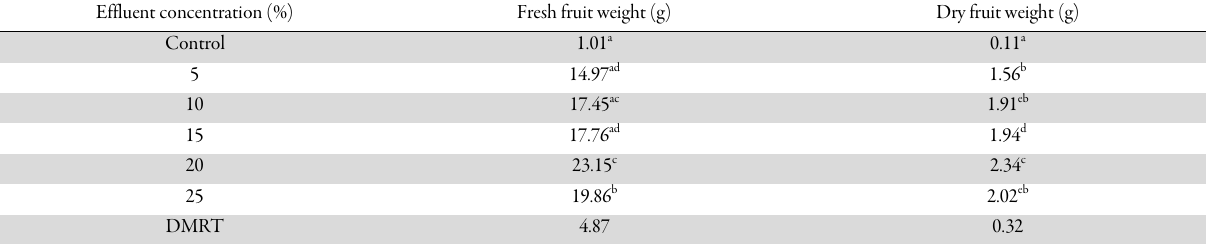
Table 7. Fresh and dry weight of fruits of Solanum lycopersicum treated with different concentrations of effluent at 16WAP Effluent concentration (%)